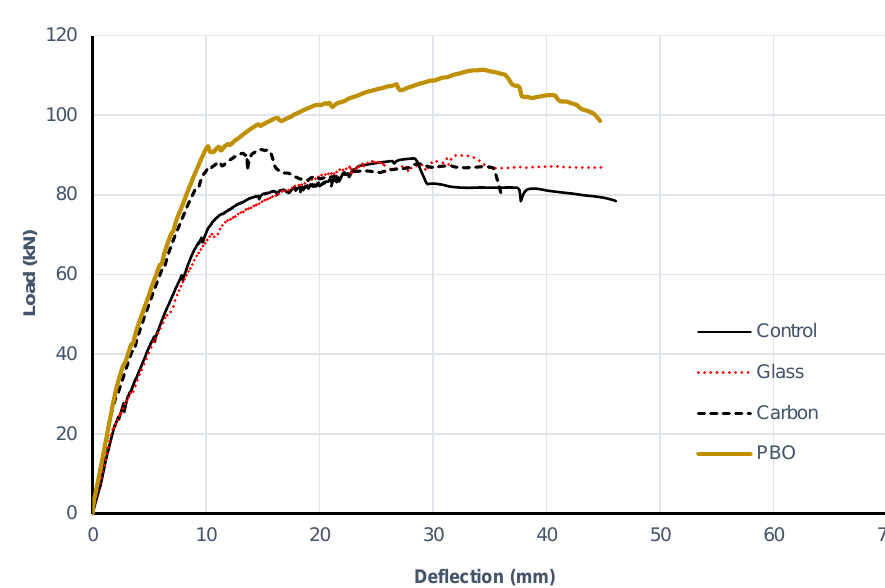
Figure 11. Load-deflection curves for Group II beams.